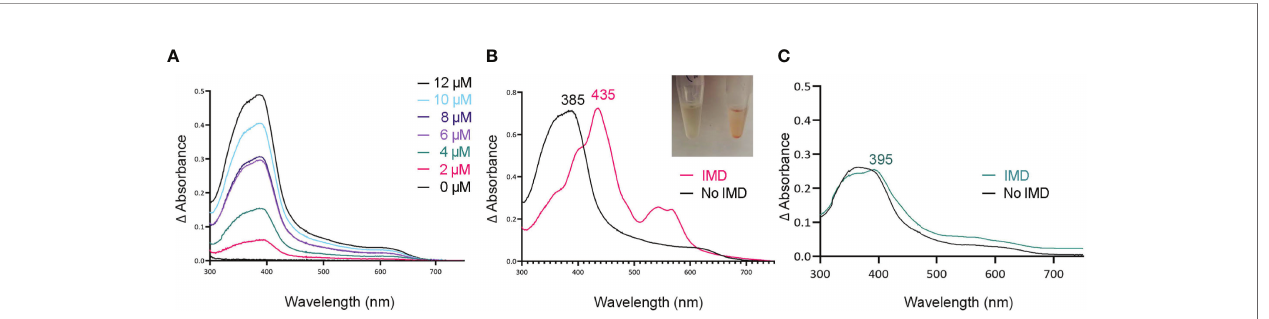
FIGURE 2 | Tag-less HupZ requires the imidazole group to coordinate heme b iron. UV-VIS absorption spectra of 10 m M tag-less HupZ (A) incubated for 1 h with a range of heme concentrations. The blank contained the reaction buffer and equivalent concentration of heme. Tag-less HupZ was incubated with 20 m M heme for 24 h, free heme was removed with PD-10 column ( B , black). Then 1.6 mM imidazole (IMD, pink) was added to the cuvette. This addition causes the solution in the test tubes to change to pink (Insert). Lastly (C) , the spectra for 10 m M of heme was taken in the standard reaction buffer (black) and with the addition of 1.6 mM IMD (teal). The blank contained only the reaction